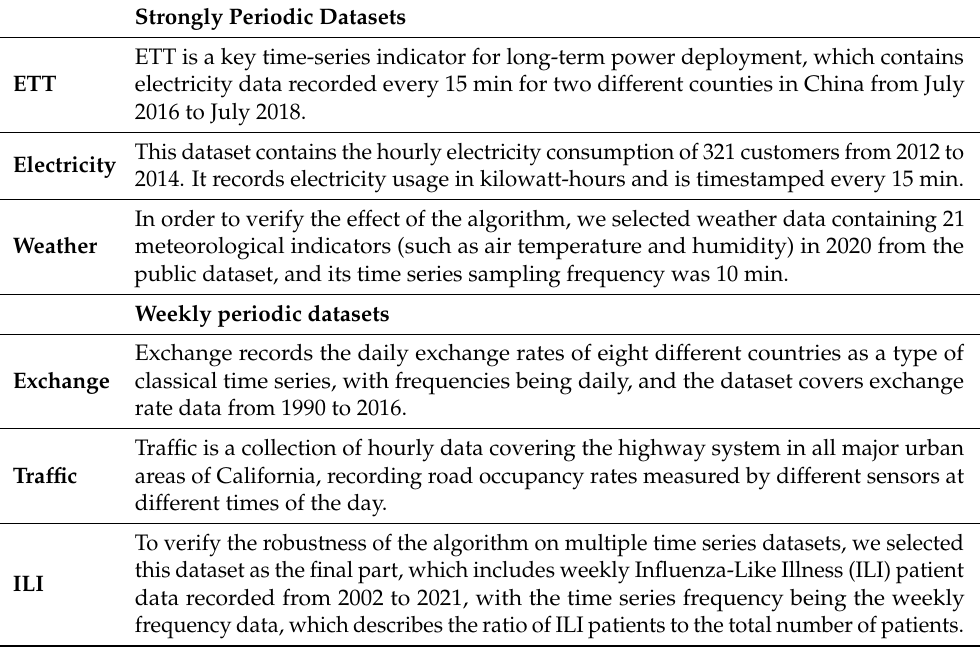
Table 1. The details of the